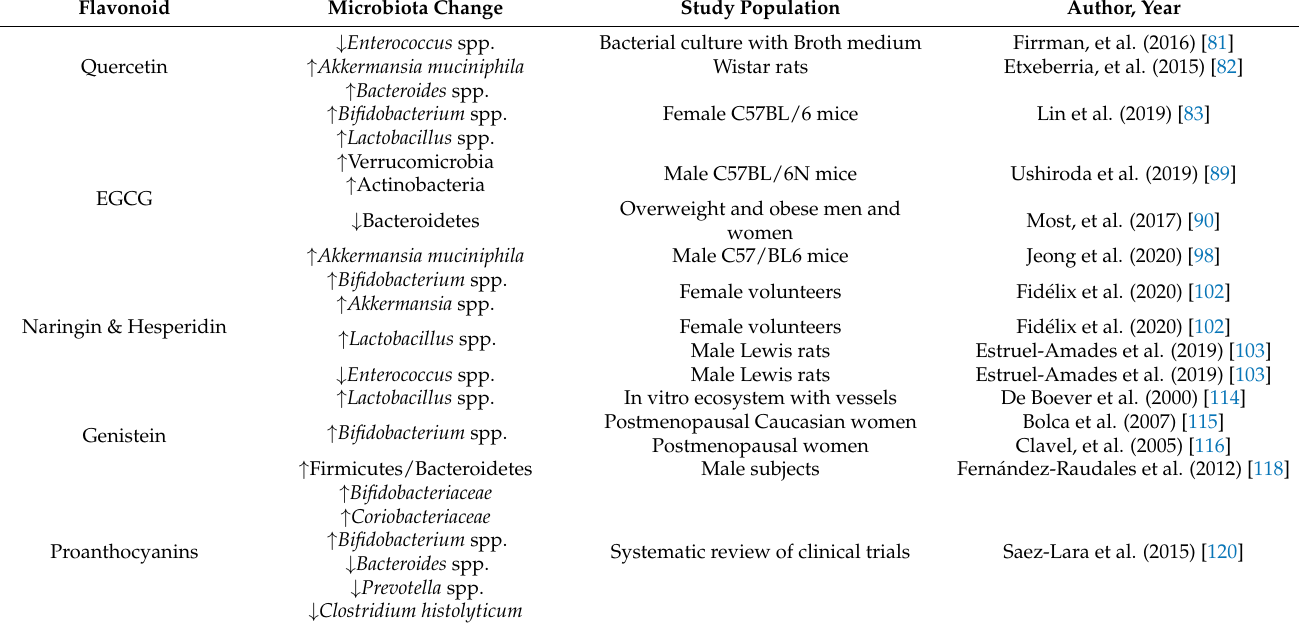
Table 1. Flavonoids effects on intestinal